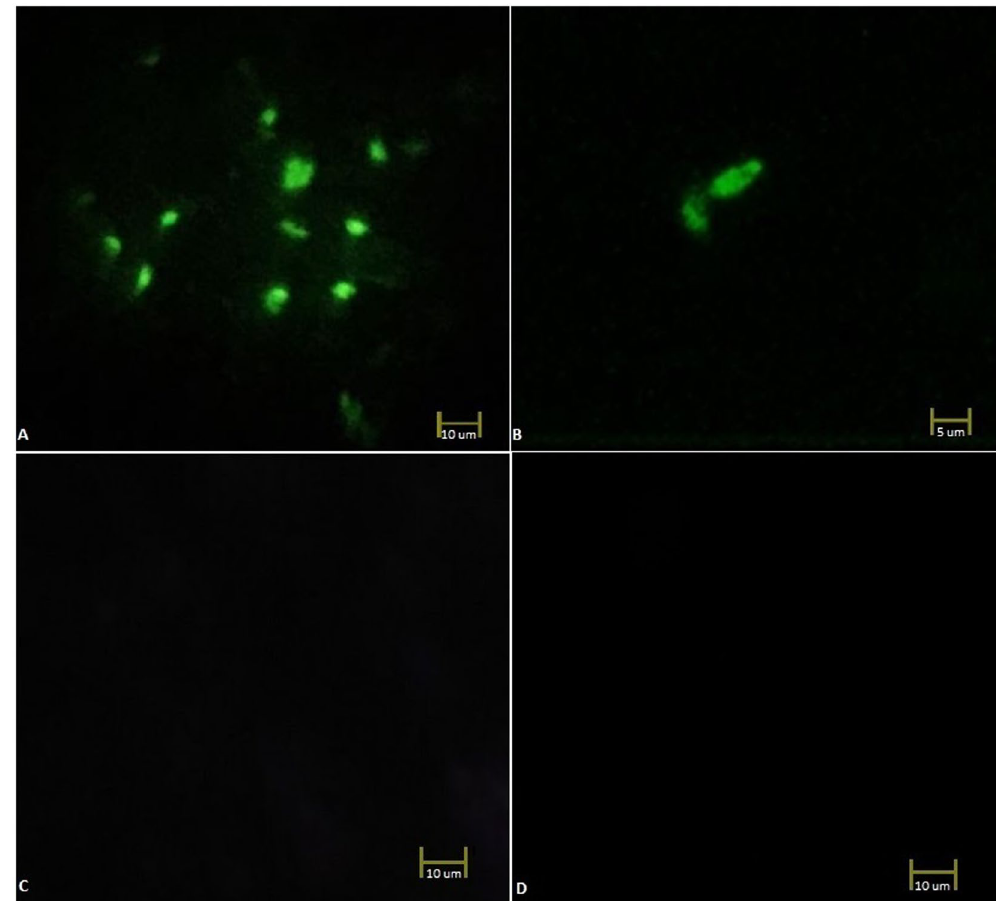
Figure 6. Microscopic images T . gondii tachyzoites (x40) stained with ( A , B ). FITC-conjugated anti-SAG1 IgY antibody, ( C ). FITC-labeled IgY Antibody Obtained from the Control Eggs, ( D ). and FITC (without